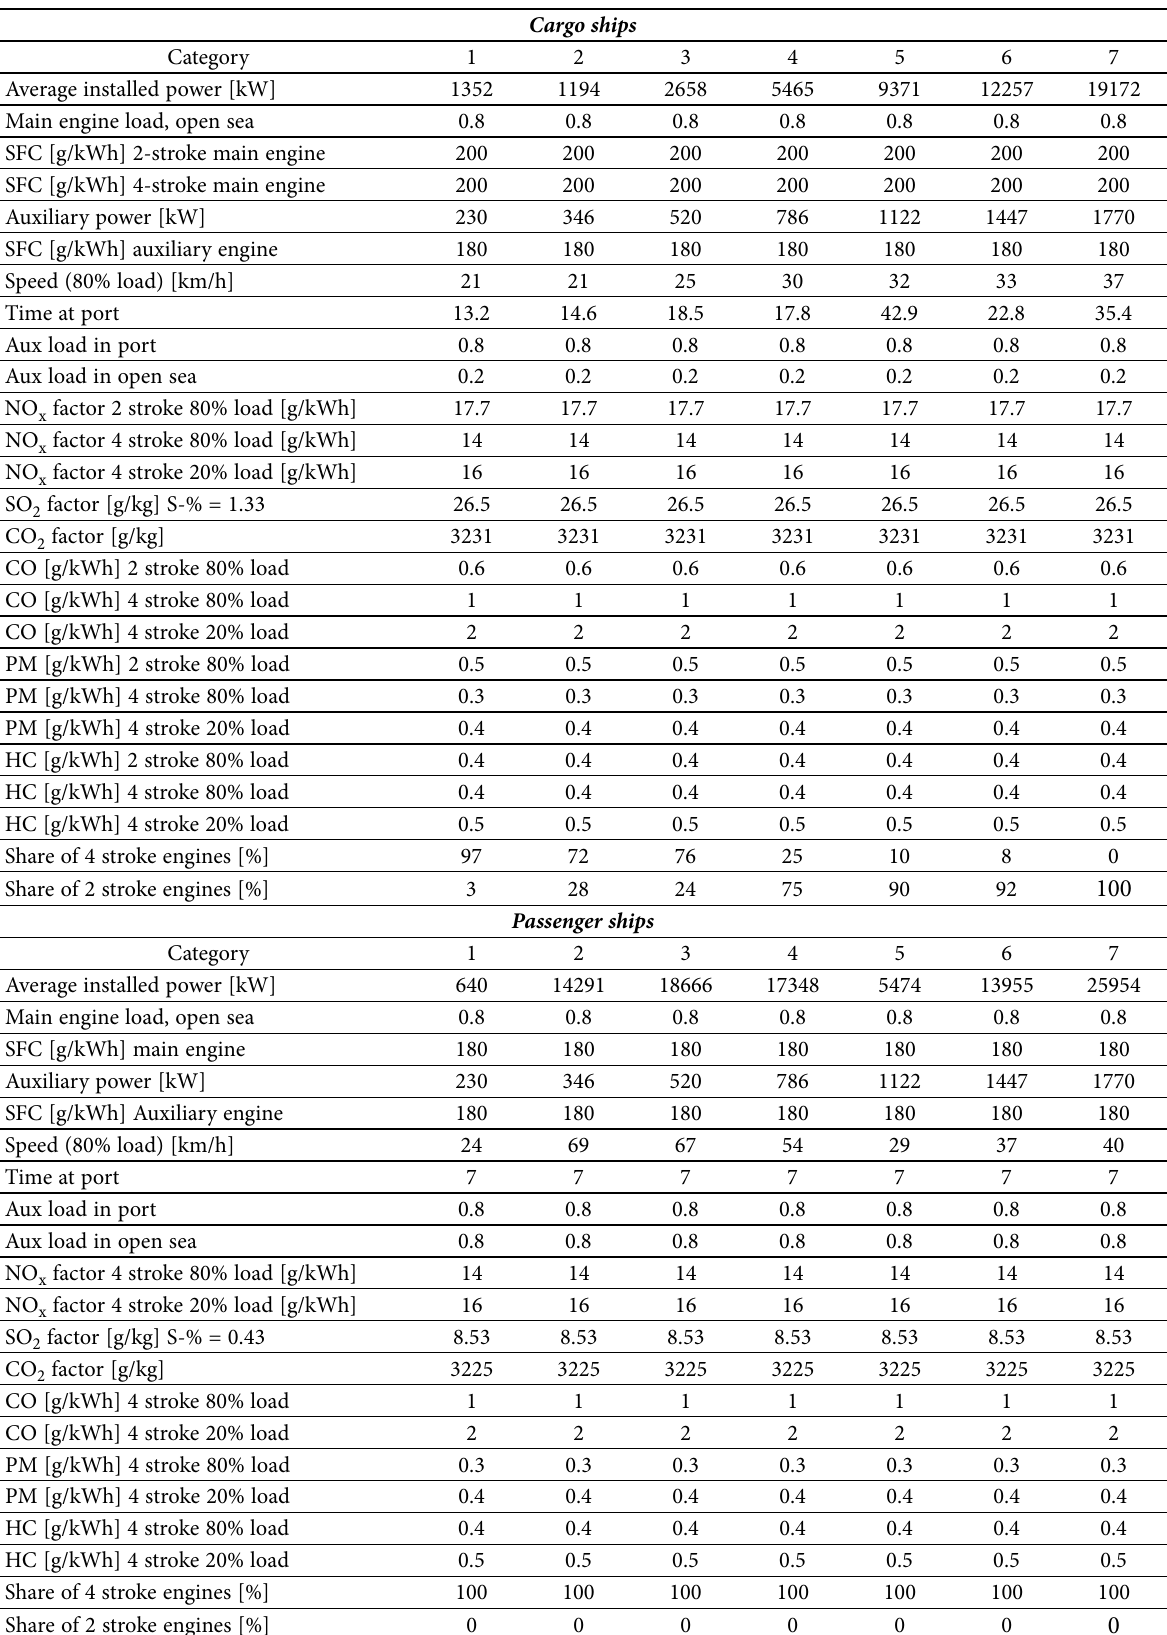
Table. Variables used for calculating emissions in the Gulf of Finland and data on traffic Cargo